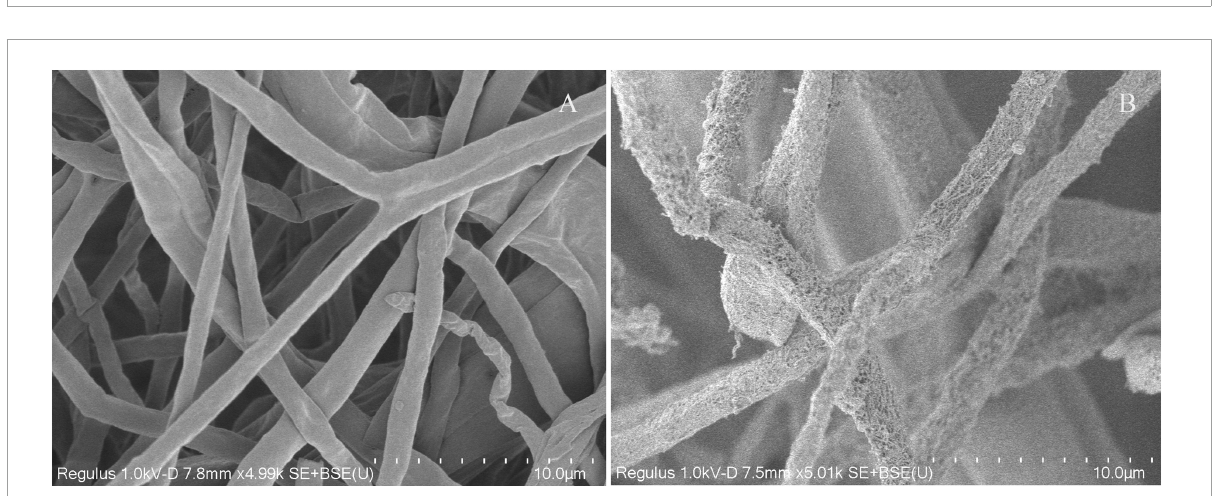
FIGURE6 The morphological changes of C. fructicola hyphae under SEM. (A) Untreated hyphae of C. fructicola (control). (B) Hyphae of C. fructicola treated with strain YYC